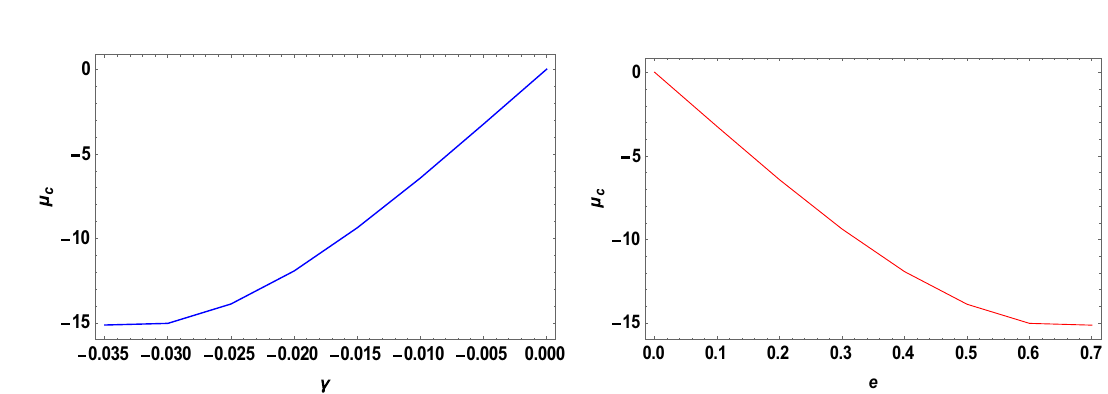
Figure 12. Effects of oblateness and potential due to belt on the Critical Mass Value (µ c ) of the triangular libration points.